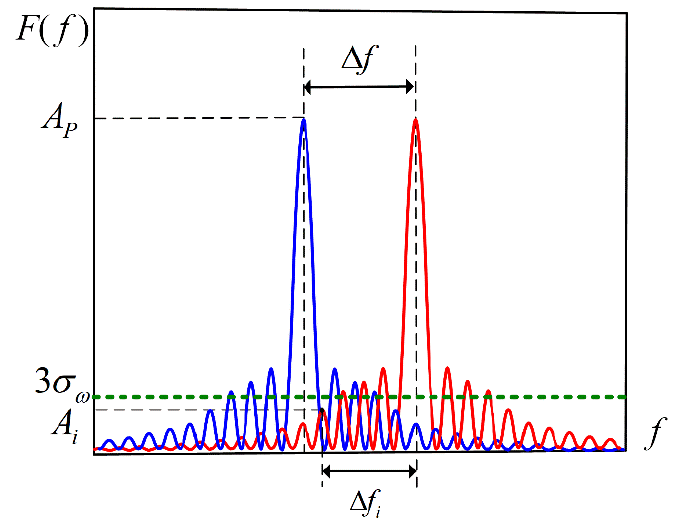
Figure 6. The schematic diagram of spectrum error analysis.